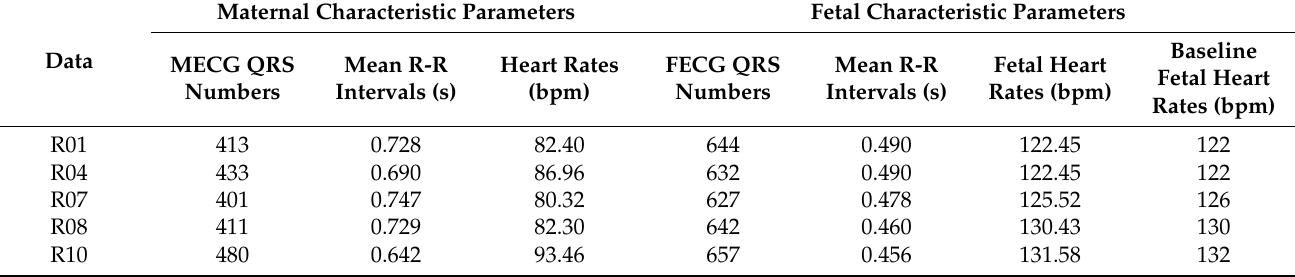
Table 4. Calculation of key characteristic